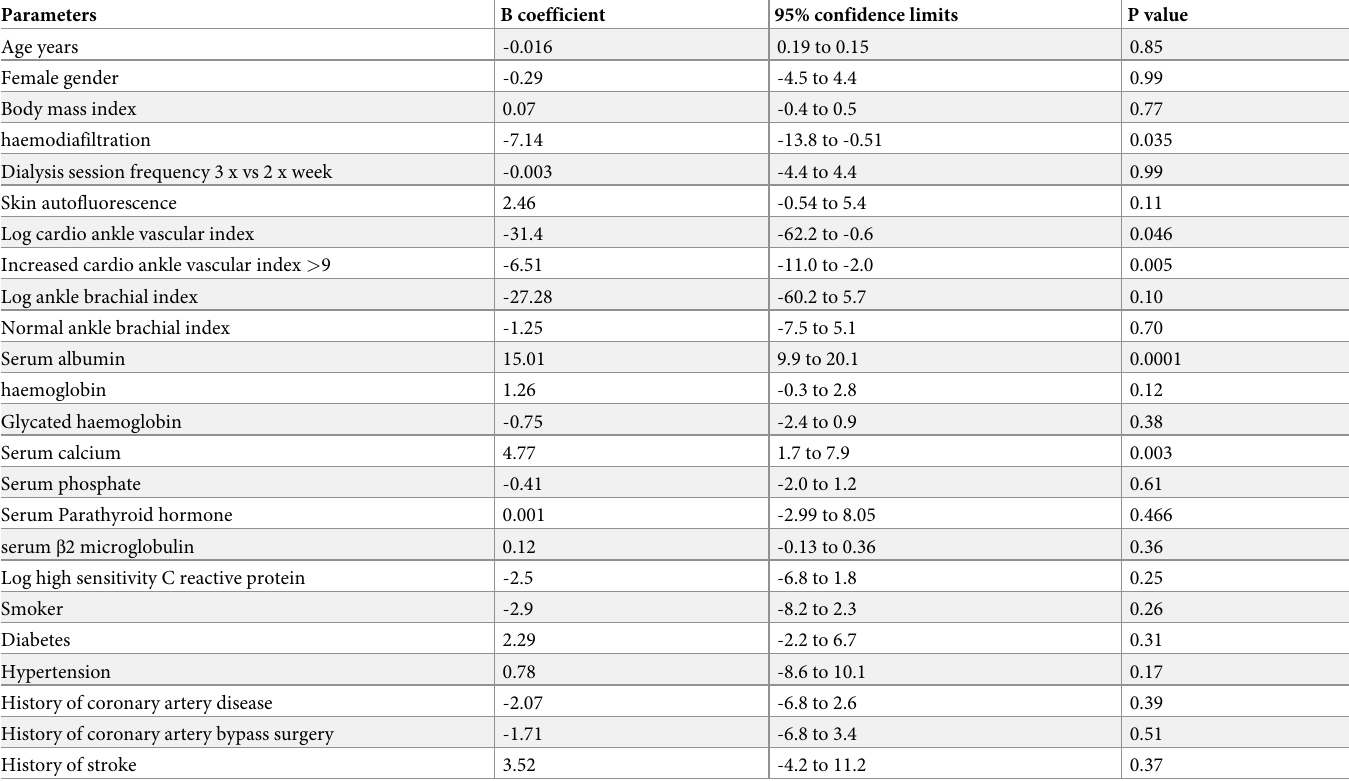
Table 2. Univariate analysis of factors associated with ischaemia modified albumin ratio